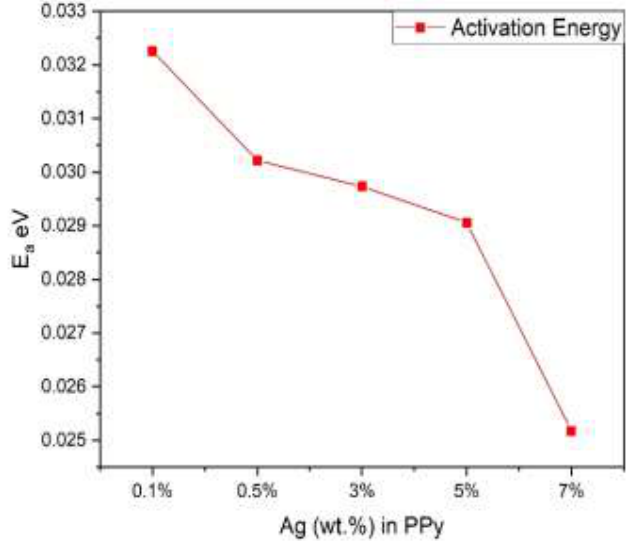
Fig.5: Variation of activation energy with Ag weight